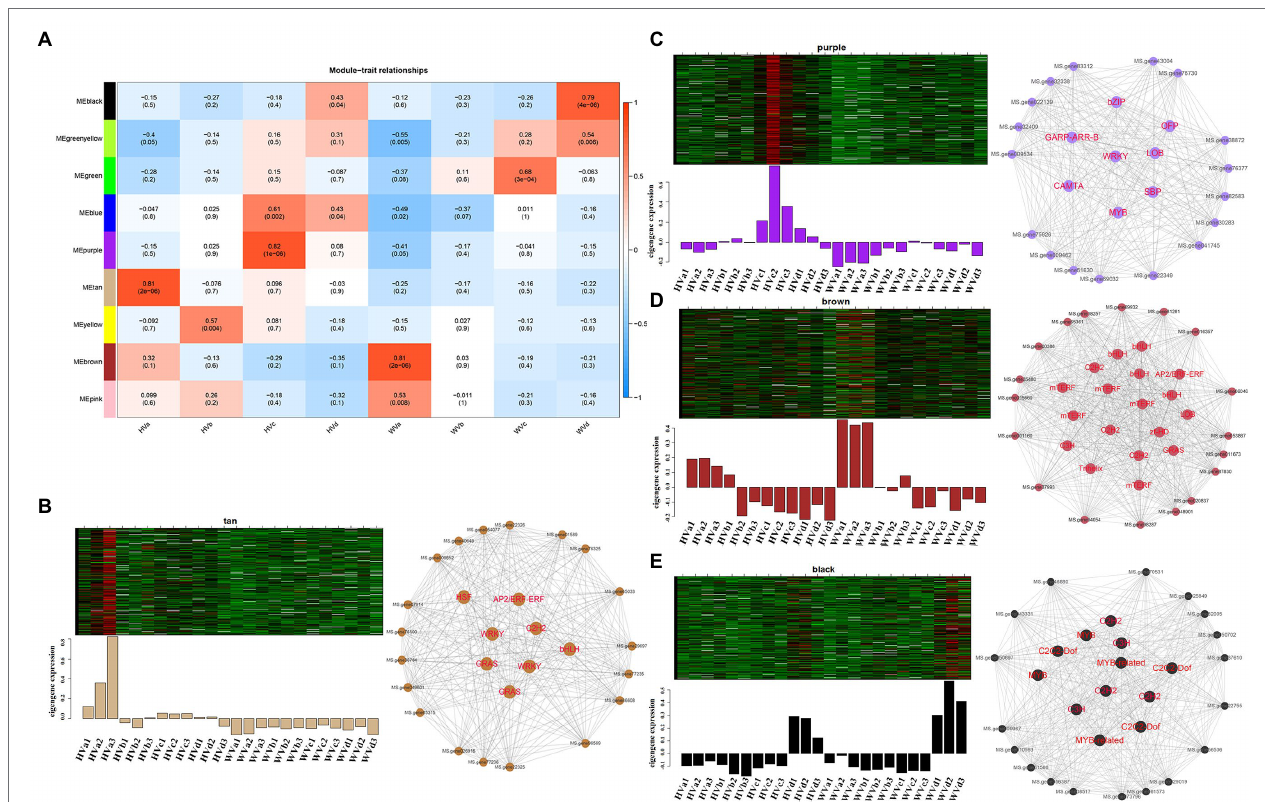
FIGURE 6 | Weighted gene co-expression network analysis (WGCNA) of module eigengenes in corresponding modules. (A) Heatmap of correlation between treatment groups and corresponding modules. (B) Heatmap and barplots of module eigengenes expression, and visualization of core genes of tan module. (C) Heatmap and barplots of module eigengenes expression, and visualization of core genes of purple module. (D) Heatmap and barplots of module eigengenes expression, and visualization of core genes of brown module. (E) Heatmap and barplots of module eigengenes expression, and visualization of core genes of black